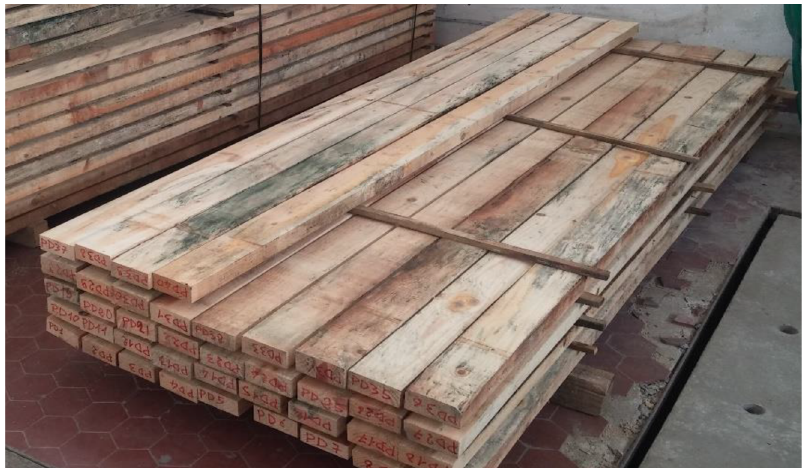
Figure 1. Sardinian maritime pine